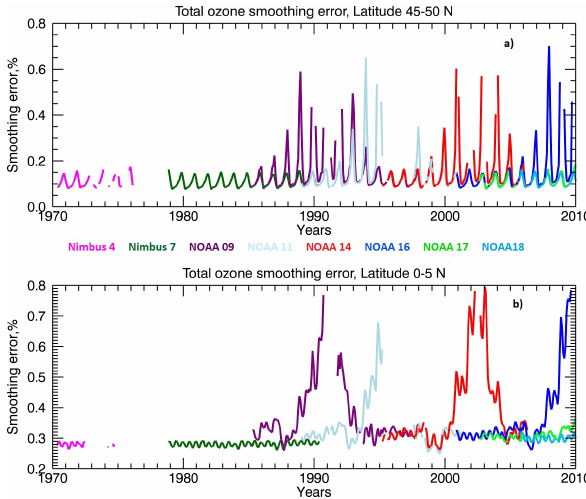
Fig. 6. Time series of the SBUV smoothing error for mzm total ozone column. (a) for 40–45 ◦ N latitude zone and (b) for 0–5 ◦ N latitude zone. Different colors correspond to individual SBUV in-